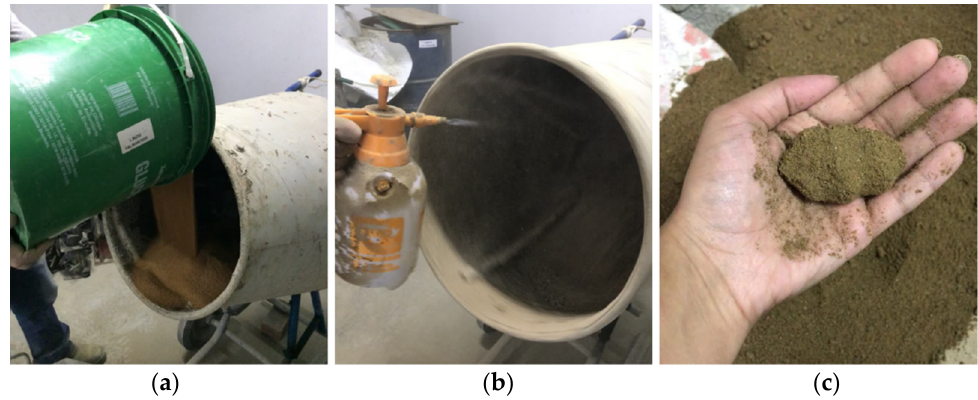
Figure 3. Steps to prepare the mixture: ( a ) mixing materials; ( b ) water addition; ( c ) optimum moisture.